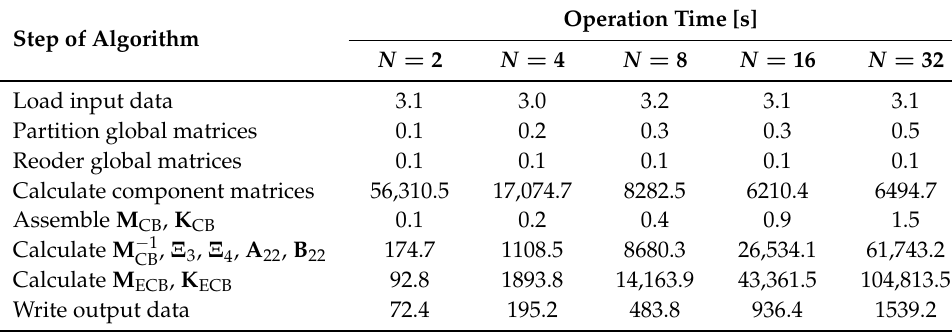
Figure 6. Example mesh, shaft assembly. Table 5. Operation time at each step of the algorithm in the shaft